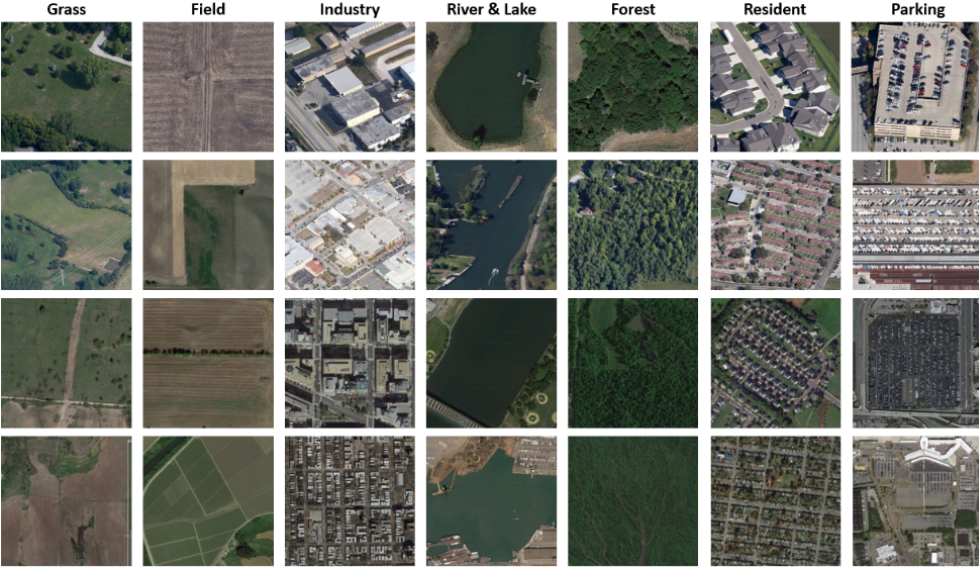
Figure 10. Images and categories of the RSSCN7 scene classification